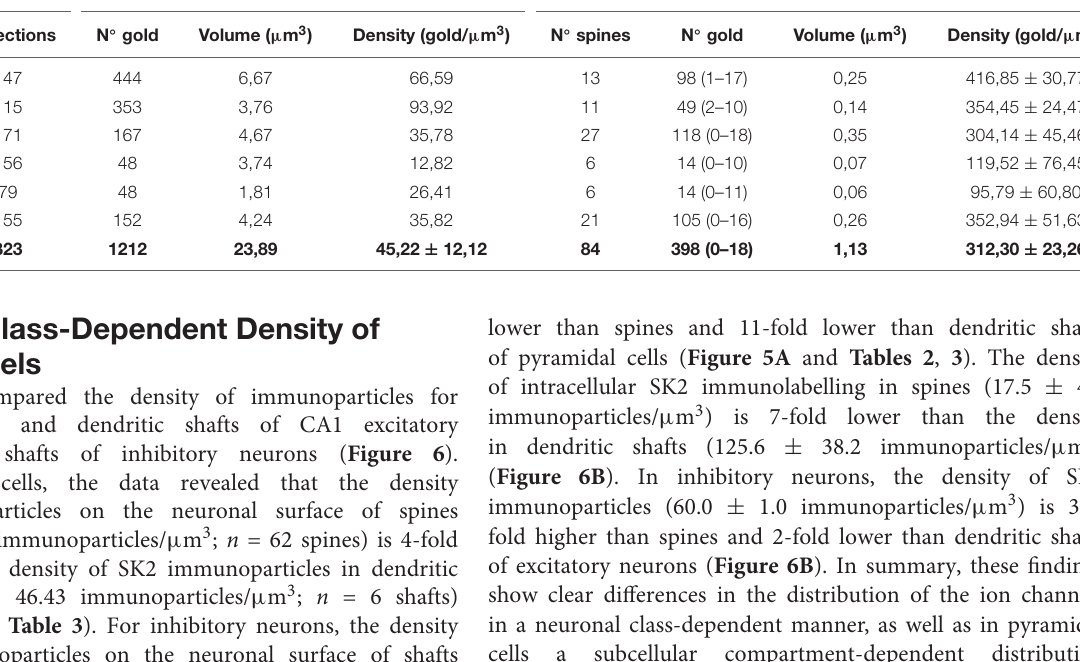
FIGURE 5 | Quantitative analysis of SK2 distribution. (A) Cumulative probability plots of SK2-to-SK2 NND. Black and red lines show real and randomly simulated SK2, respectively. The distribution of real SK2 immunoparticles differs significantly from random distribution (* P < 0.0001). (B) SK2 immunoparticles composition of clusters along the neuronal surface of CA1 pyramidal cells. Sixty four percent of clusters were composed of 3–8 SK2 immunoparticles. (C) Percentage of SK2 immunoparticles in dendritic shafts and spines of pyramidal cells and interneurons at intracellular sites vs. plasma membrane, demonstrating differential distribution patterns. Dendritic spines contained a high proportion of SK2 along the extrasynaptic plasma membrane, while interneurons have major expression intracellularly with very low presence on the surface. (D) Scatter plot showing the strong positive correlation between the volume of spines and numbers of gold particles labeling SK2 (R = 0.84, Pearson’s correlation coefficient). (E) The histogram shows large variability in SK2 density at spines of pyramidal cells. Spines as shown in the first column (26% of total, 22 out of 84 spines) failed to display SK2 immunoparticles. (F) Quantitative analysis showing mean volume of spines immunopositive for SK2 (spines SK2 +) and immunonegative for SK2 (spines SK2-) in the stratum radiatum of the CA1 region. On average, the mean volume of spines SK2+ is significantly larger (0.0152 ± 0.001 µ m 3 ) than that of SK2- (0.0079 ± 0.001 µ m 3 ) (Mann-Whitney test, P < 0.001). TABLE 3 | Number and density of immunoparticles for SK2 on 3D reconstructed dendritic spines and shafts of CA1 pyramidal cells. CA1 pyramidal cell Dendritic shafts